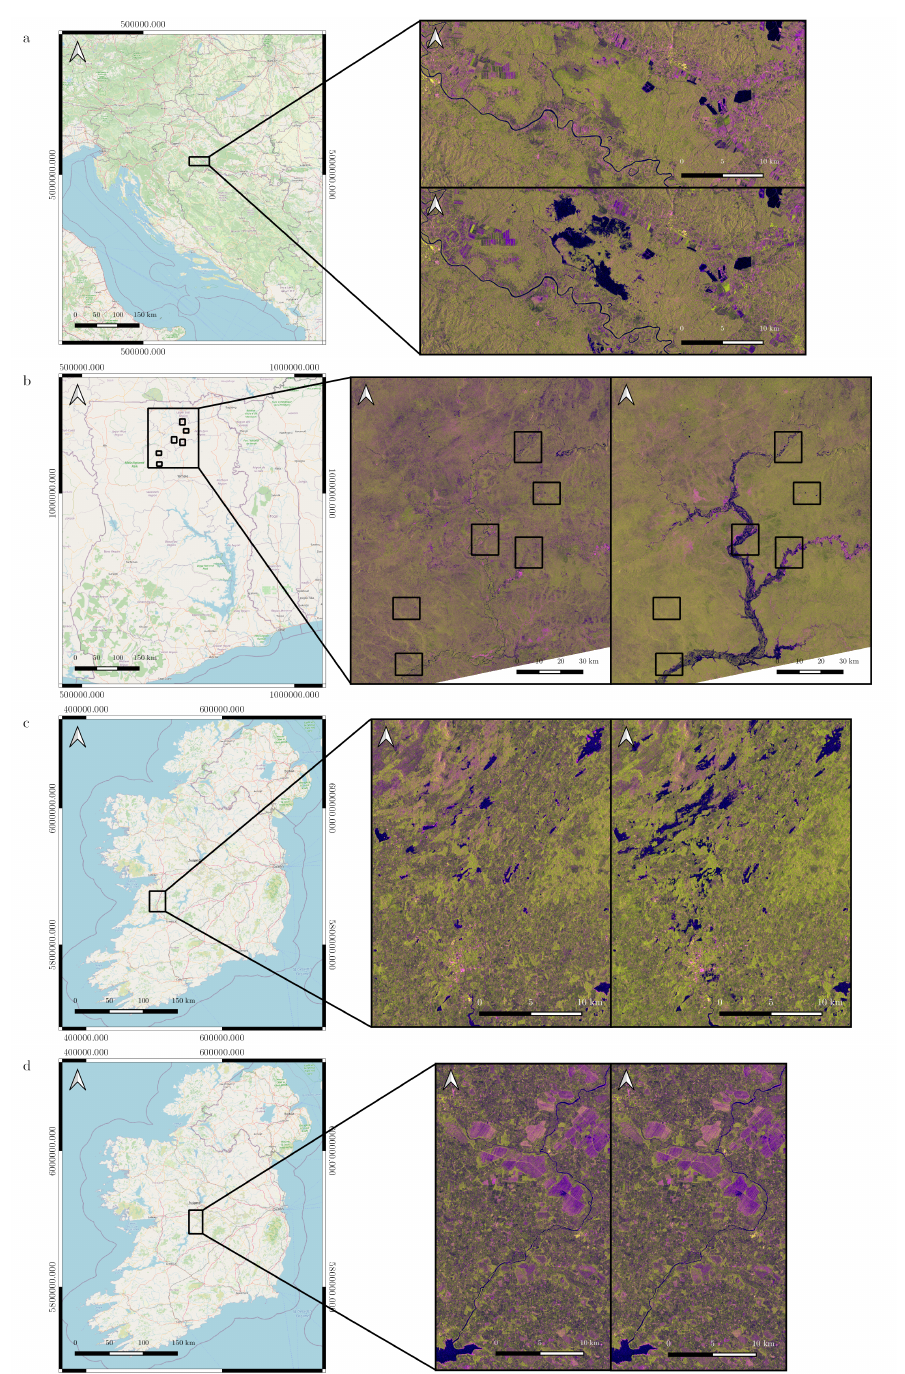
Figure 1. Overview of the study cases and Synthetic Aperture Radar (SAR) data used in this study. The imagery for the Sava ( a ), Volta ( b ), Fergus ( c ), and Shannon ( d ) regions of interest (ROIs) are displayed in EPSG 32,633, 32,630, 32,629, and 32,629, respectively. The SAR reference and flood images are shown as (VV,VH,VV/VH) composites, with visualization limits (